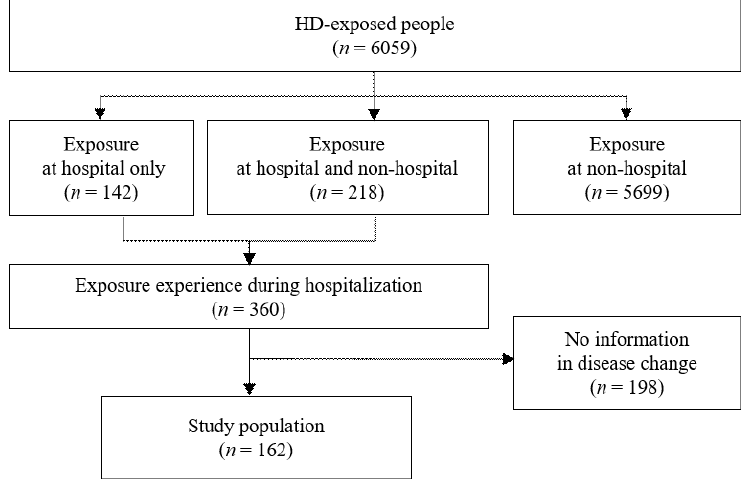
Figure 1. Flow chart showing the selection of study population.